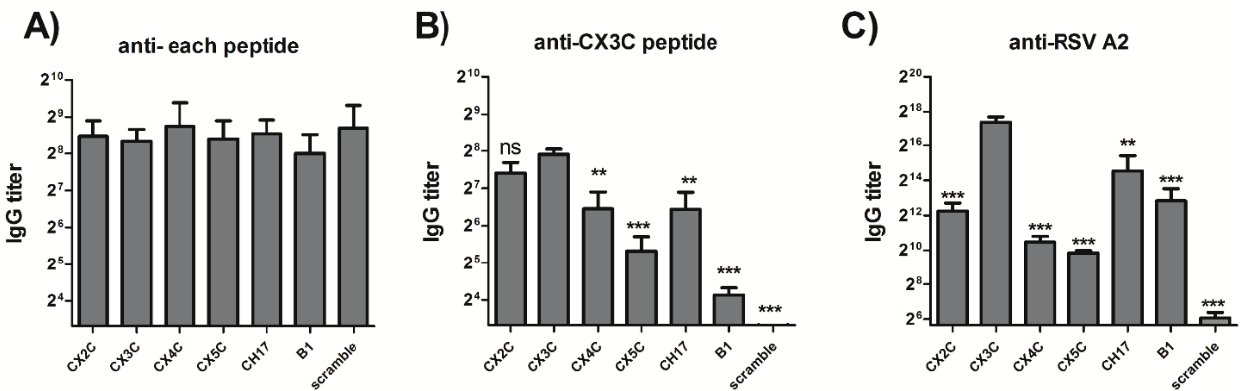
Figure 2. Antibody response to peptide vaccination. Serum IgG was measured in the serum of vaccinated animals at day 49 post vaccination (Study 1, n = 5). IgG against each respective G peptide ( A ), CX3C peptide ( B ) or RSV A2 ( C ) were detected by indirect ELISA